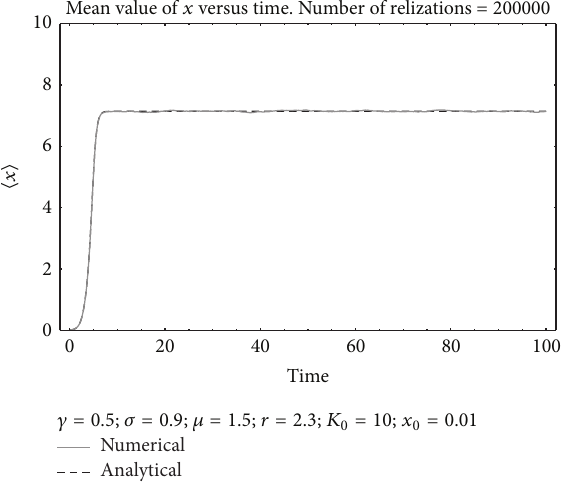
Figure 1: The plot of the mean value of 𝑥(𝑡) versus time in arbitrary units. The values of the parameters are 𝑥 0 = 1 , 𝛾 = 0.2 , 𝜎 = 0.5 , = 13 , and 𝑟 = 1 . The analytical value of ⟨𝑥(𝑡)⟩ is given by 𝜇 = 1.9 , 𝐾 0 (18). The agreement between the analytical expression (dashed line) and the numerical simulation (continuous line) is remarkable.